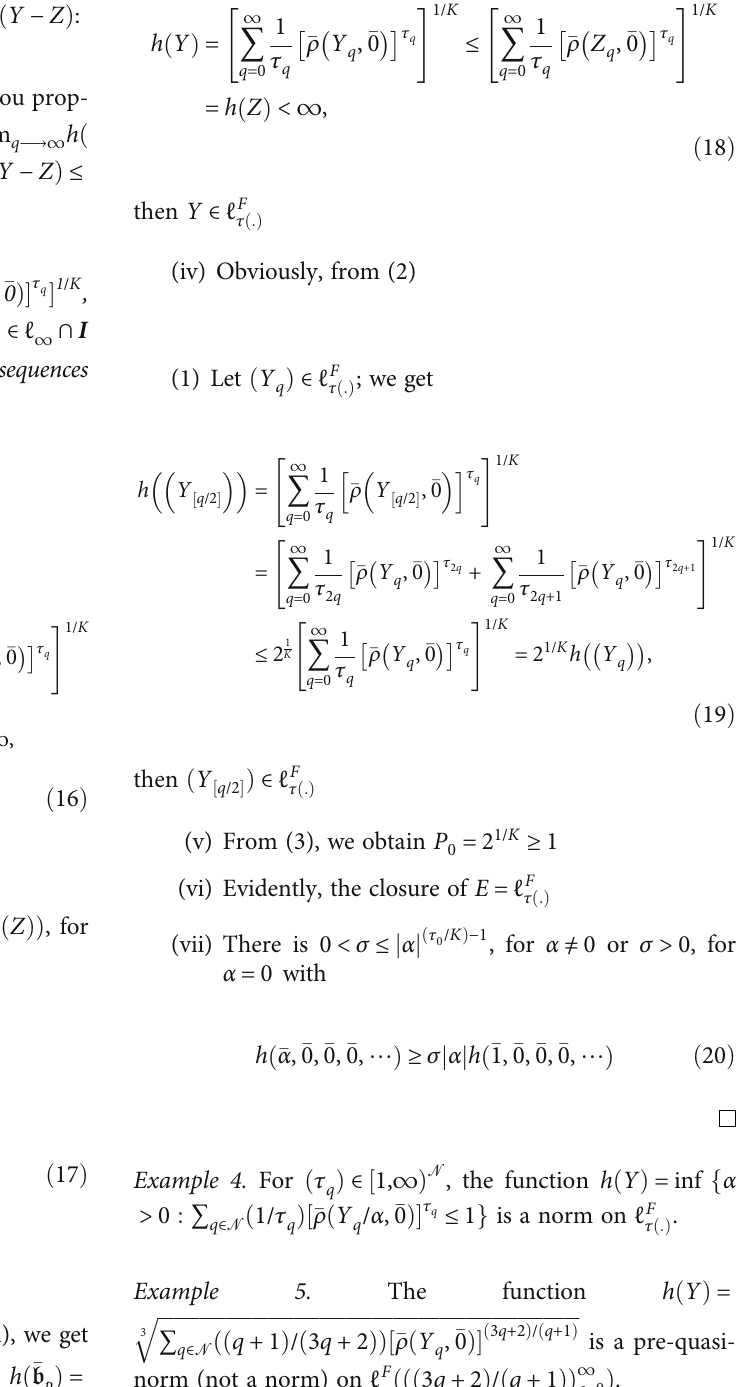
Example 7. The function h ð Y Þ